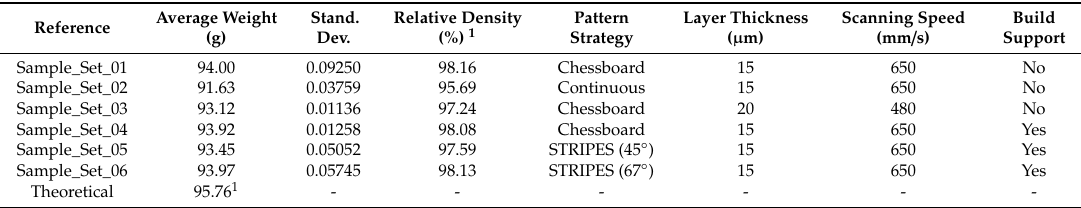
1 – determined by the weight di ff erence between real and 3D scanned sample weights.